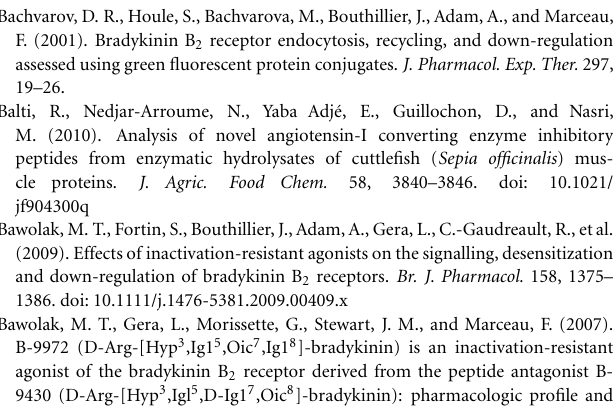
FIGURE 7 | Effect of BK-related peptides (100 nM) added to the serum-supplemented culture medium of HEK 293 stably expressing B 2 R-GFP on the cycling of this fusion protein. Green epifluorescence (original magnification 1000 × ).The effect of co-treatment with peptidase inhibitors is shown for the shorter incubation period (30 min).The effect of